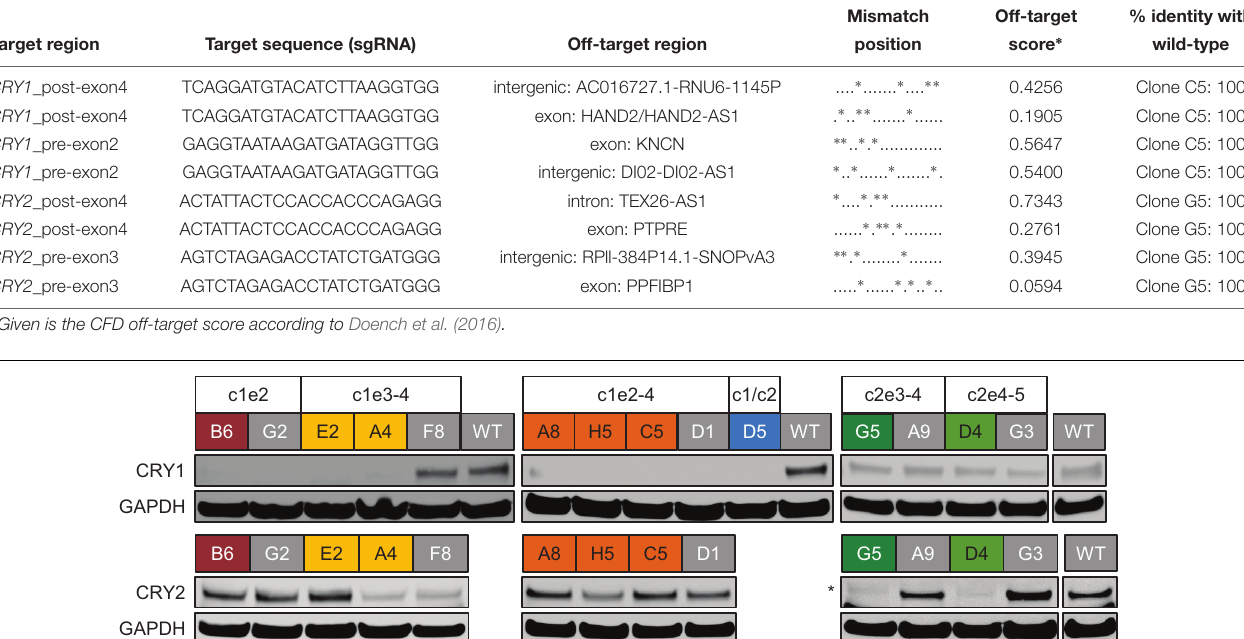
TABLE 1 | Analysis of potential off-target effects of CRISPR/Cas9-mediated genome editing.